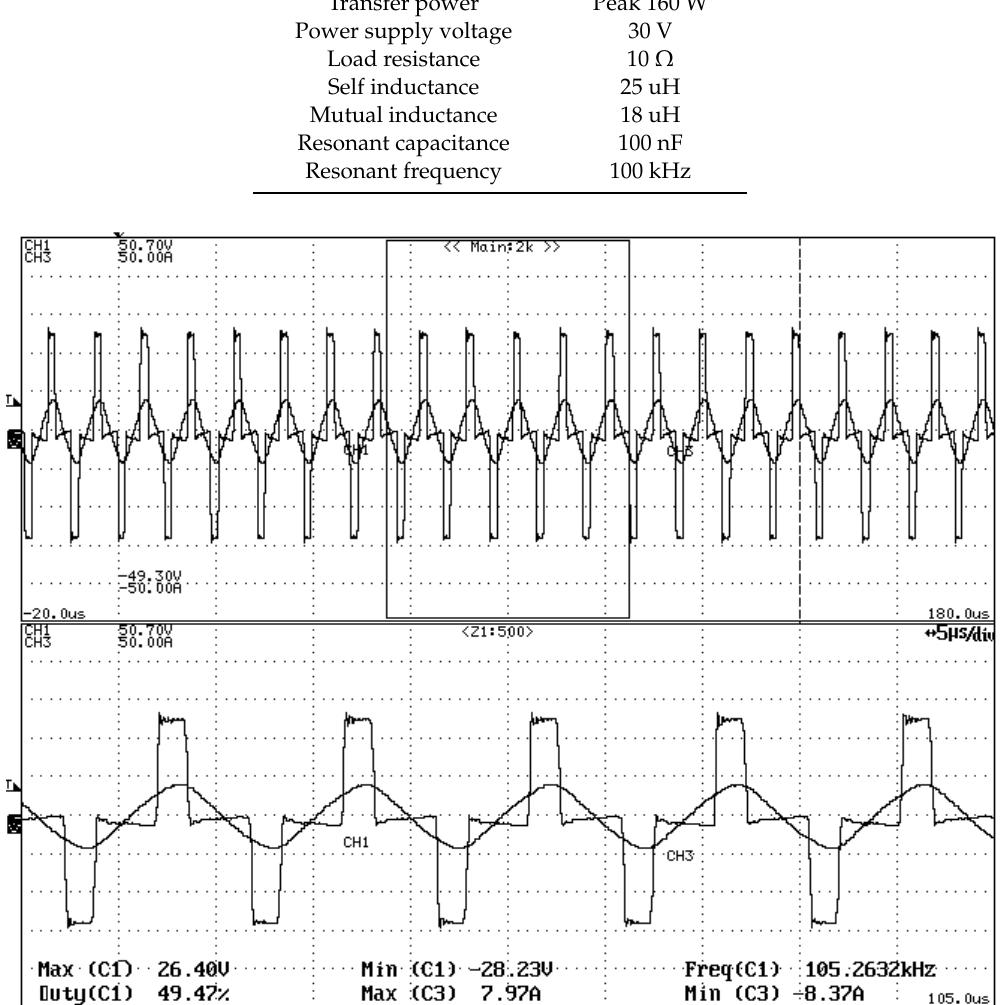
Figure 9. The excitation voltage and current on the primary side